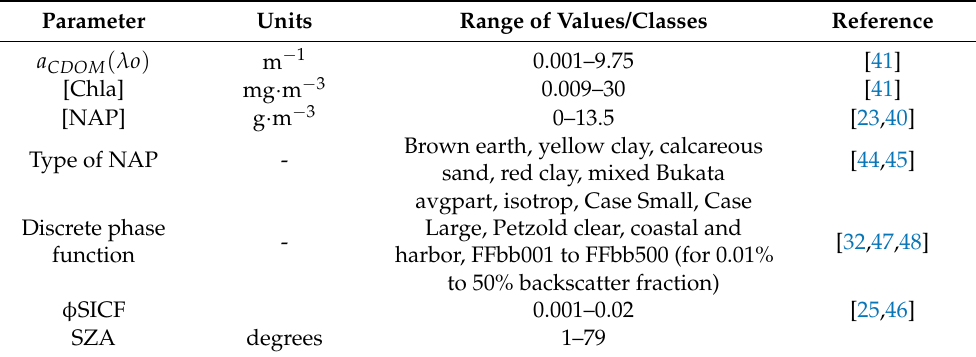
Table 2. Variation of parameters to simulate the validation database